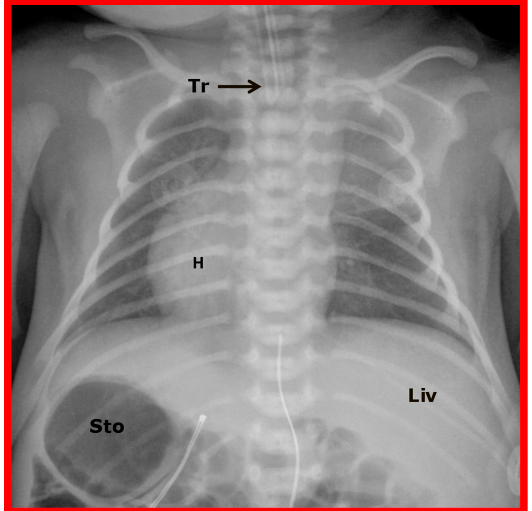
Figure 8. A chest roentgenogram of an infant demonstrating that the heart (H) is located in the right